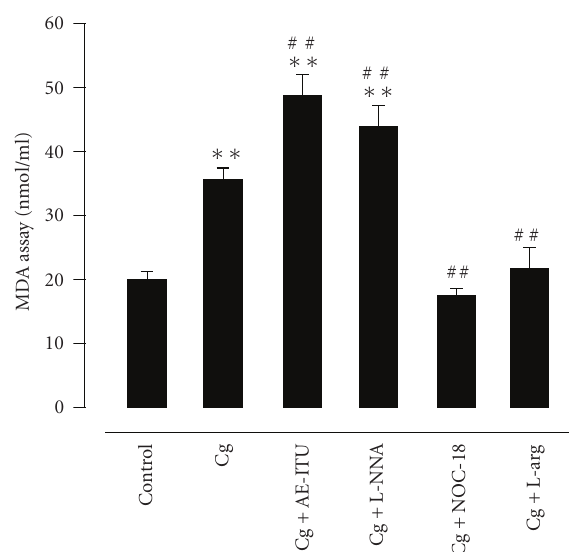
Figure 6: E ff ect of AE-ITU, L-NNA, NOC-18, and L-arginine on malondialdehyde (MDA) content in the pleural exudates 6 hours after Cg challenge. Data are expressed as mean ± S.E.M. of 6 to 8 rats. ∗∗ P < . 01 as compared to control group; ## P < . 01 as compared to Cg